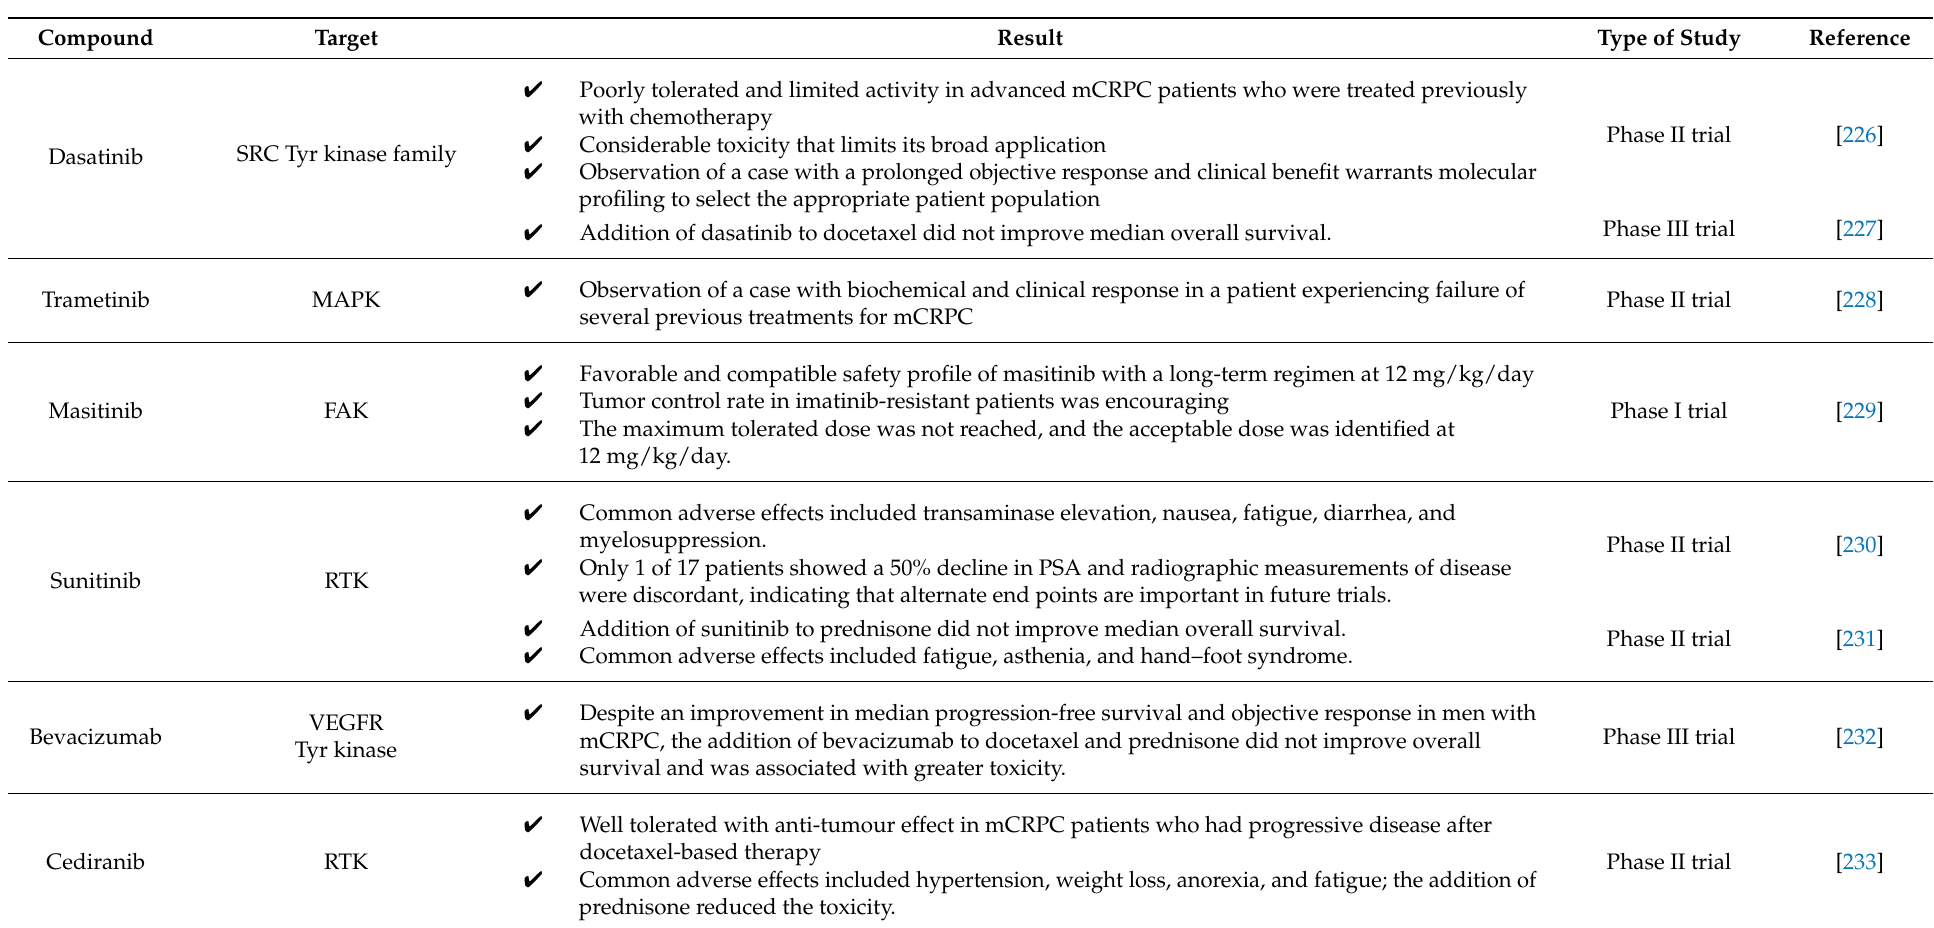
Table 1. Summary of several active and completed clinical trials evaluating the efficacy of some kinase inhibitors in monotherapy and in combination with other treatments in